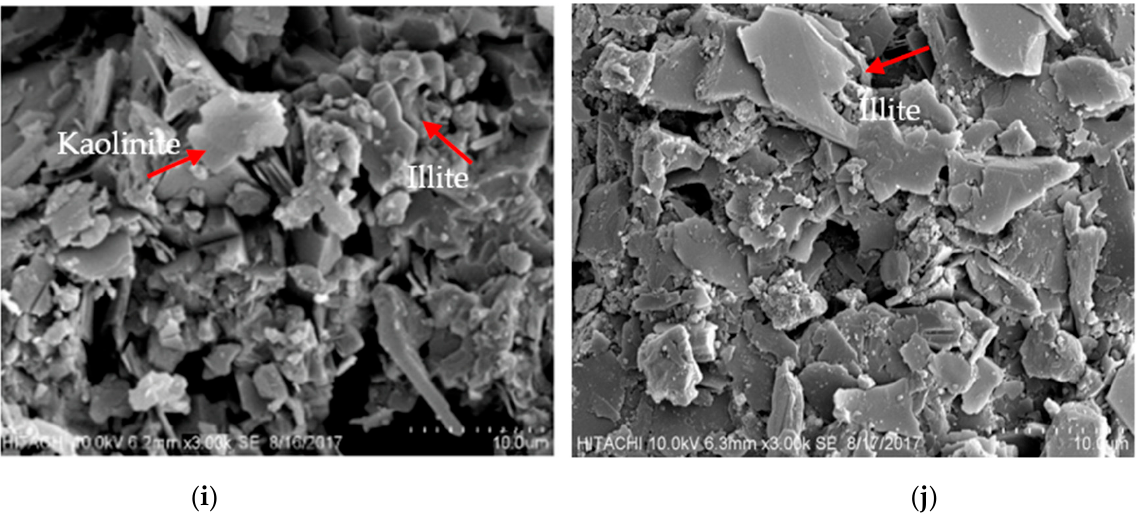
Figure 5. Scanning electron micrographs (SEM) images for different samples. Rock samples: waste dump ( a ), high-grade stockpile ( b ), super-low-grade stockpile ( c ), low-grade stockpile ( d ). Sediment sample ( e ), sludge sample ( f ), soil samples waste dump ( g ), high-grade stockpile ( h ), super-low-grade stockpile ( i ), and low-grade stockpile ( j ) at ×3.00 k magnification.